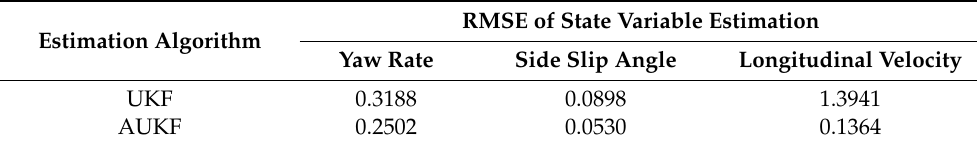
Table 1. RMSE of the two algorithms during the entire duration of the process. RMSE of State Variable Estimation Estimation Algorithm Yaw Rate Side Slip Angle Longitudinal Velocity UKF 0.3188